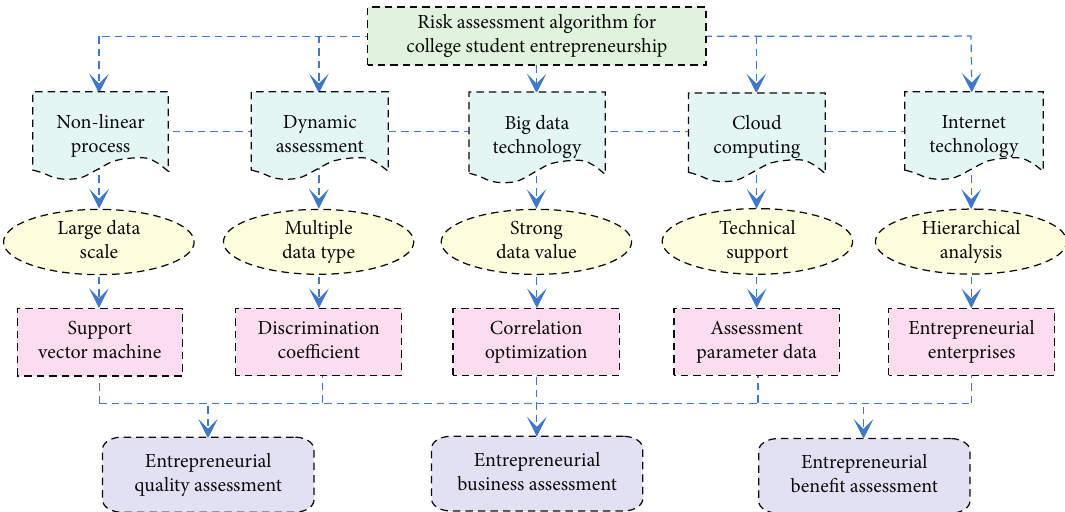
Figure 1: Risk assessment framework for college student entrepreneurship based on big data